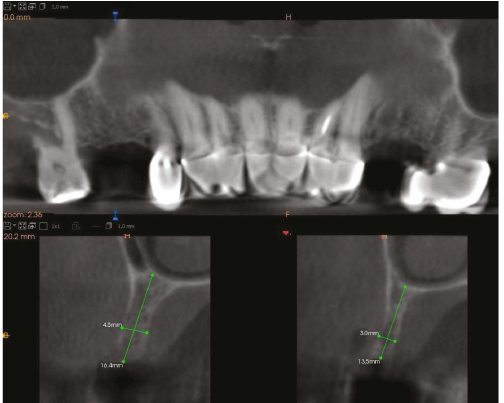
Figure 1: A CBCT scan of the patient with a very thin maxillary alveolar